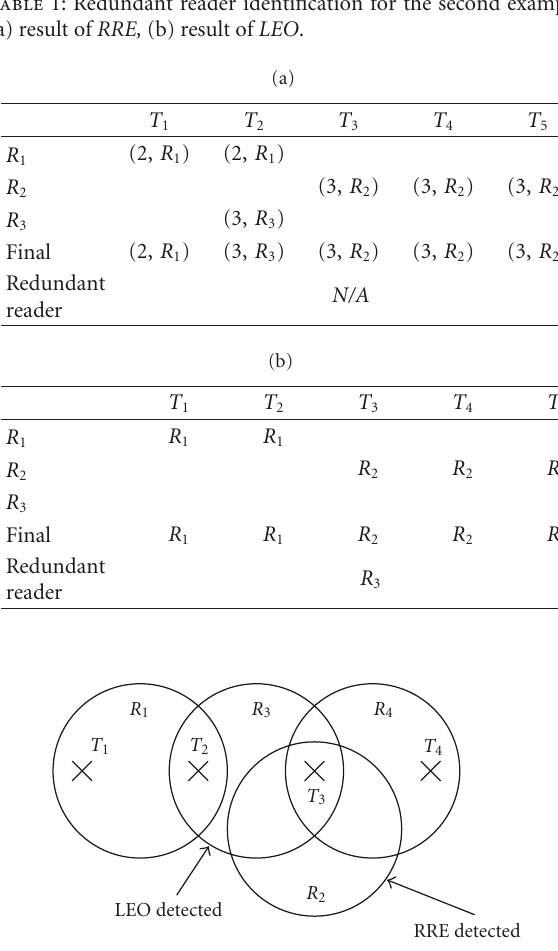
Figure 4: The third example of redundant reader.